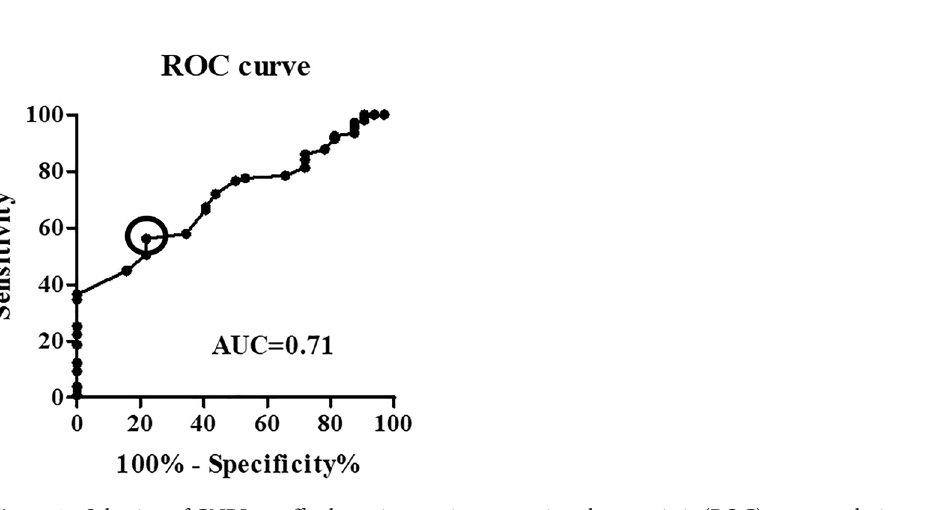
Figure 1. Selection of GNRI cutoff value using receiver operating characteristic (ROC) curve